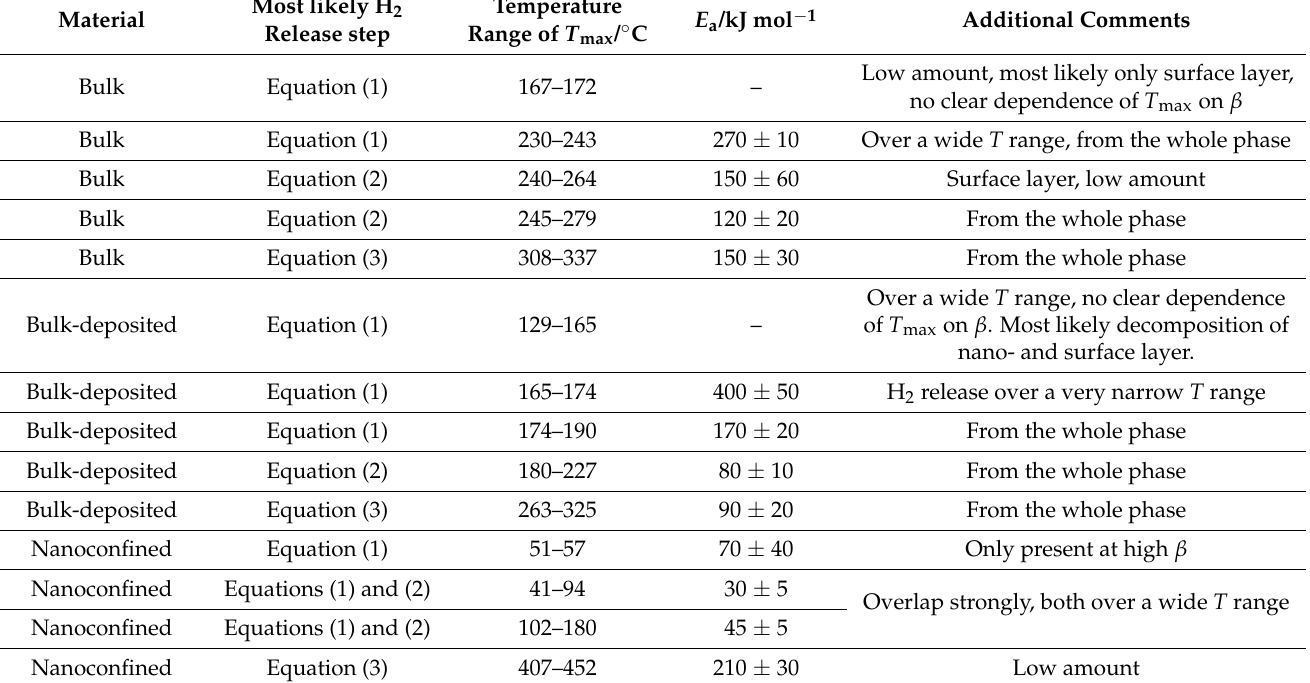
Table 1. Hydrogen release peaks and Kissinger method fitting